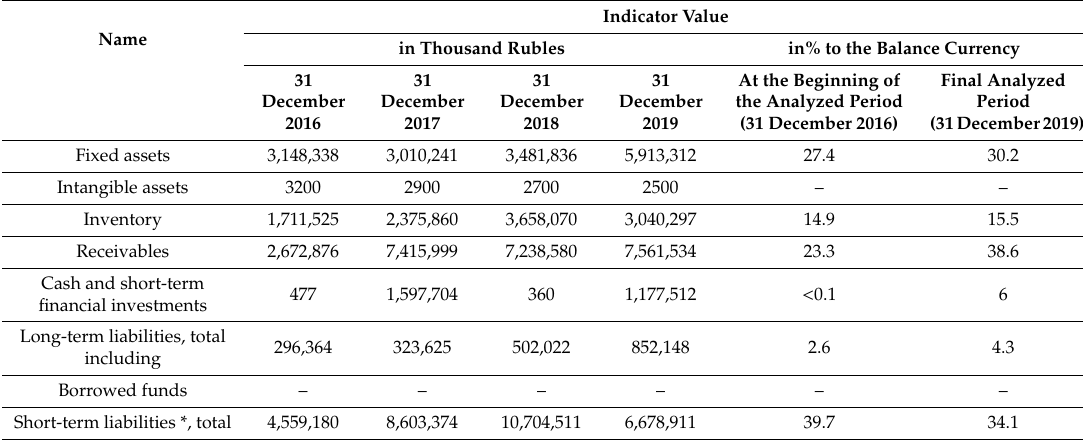
Table A4. Analysis of indicators of the company (annual data, yearly